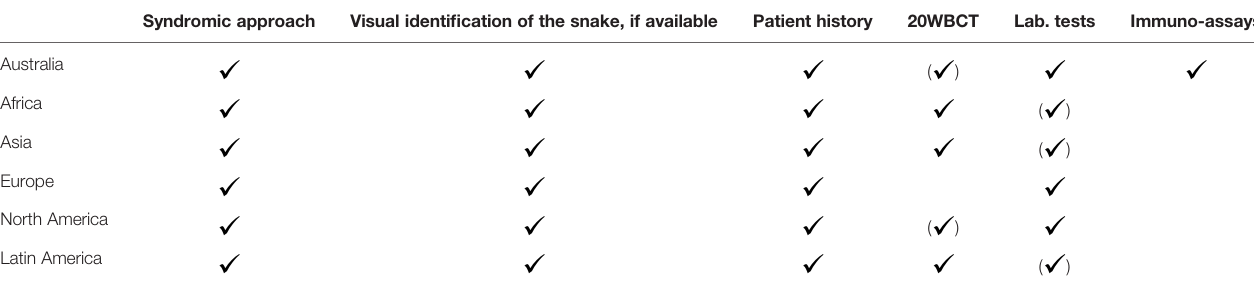
TABLE 3 | Overview of clinically commonly used diagnostic methods for snakebite envenoming in different parts of the world. Syndromic